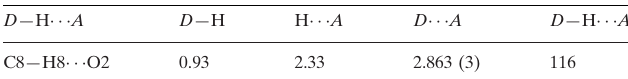
Hydrogen-bond geometry (A˚ , (cid:2) ).